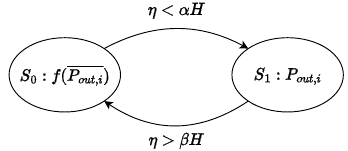
Figure 10. The two-state finite state